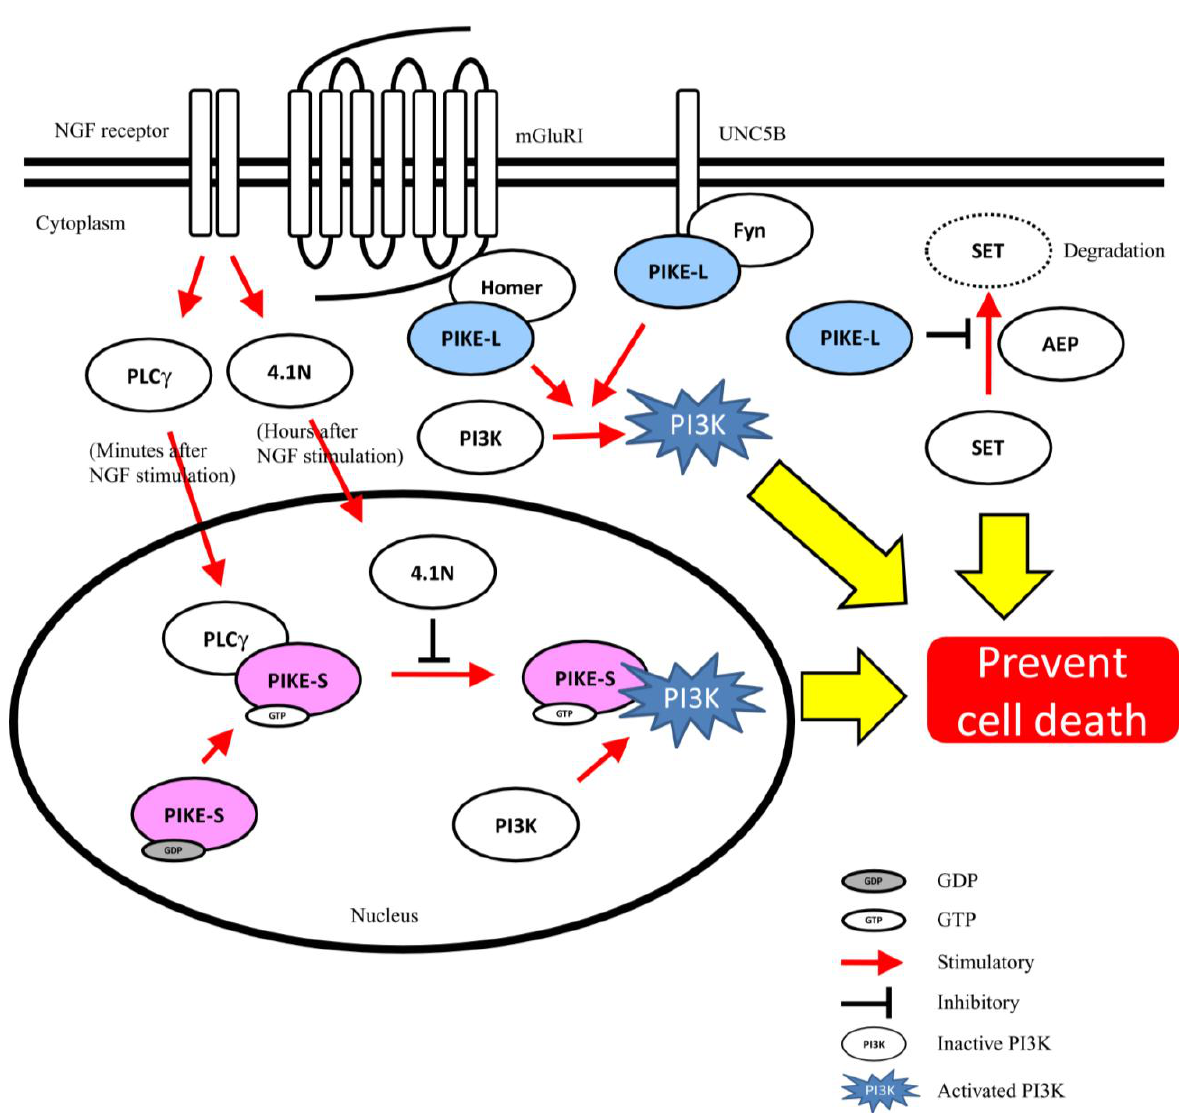
FIGURE 1. Mechanisms of PIKE-L and PIKE-S in inhibiting